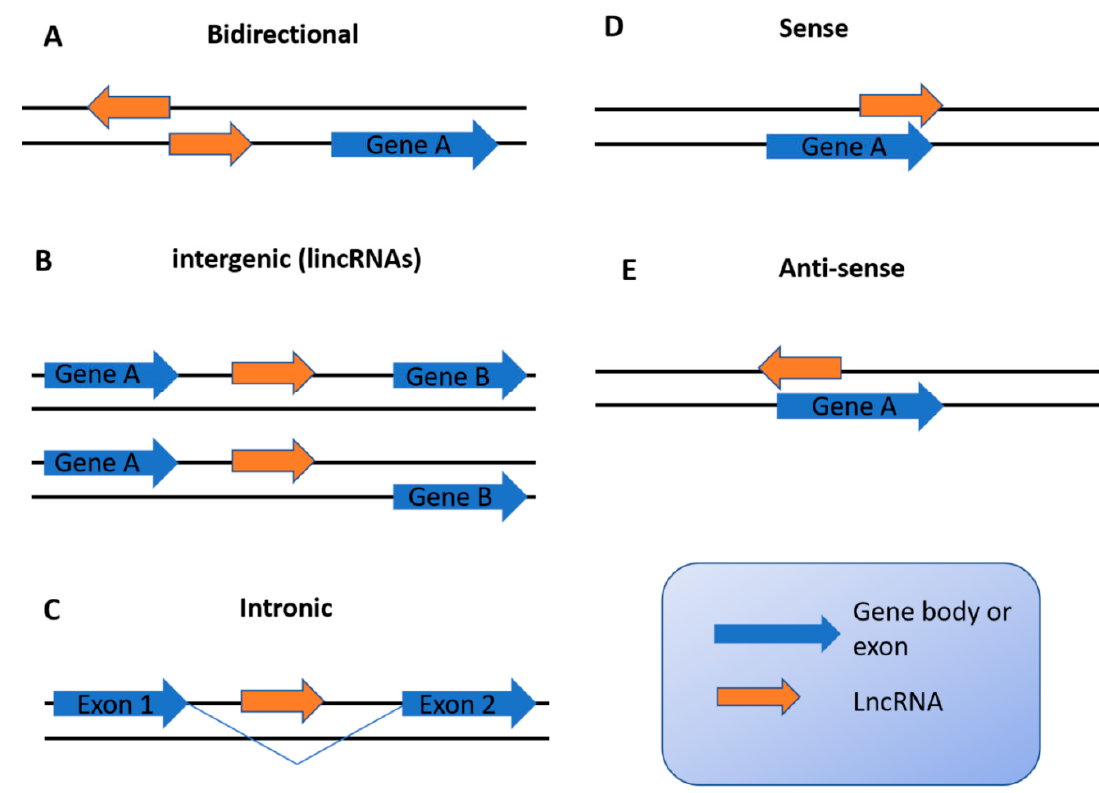
Figure 1. lncRNA classification according to their relative position to protein coding genes. Based on the genomic locali- zation relative to protein-coding genes, lncRNAs can be classified into 5 categories: ( A ) bidirectional, ( B ) intergenic (lin- cRNAs), ( C ) intronic, ( D ) sense, and ( E ) antisense.